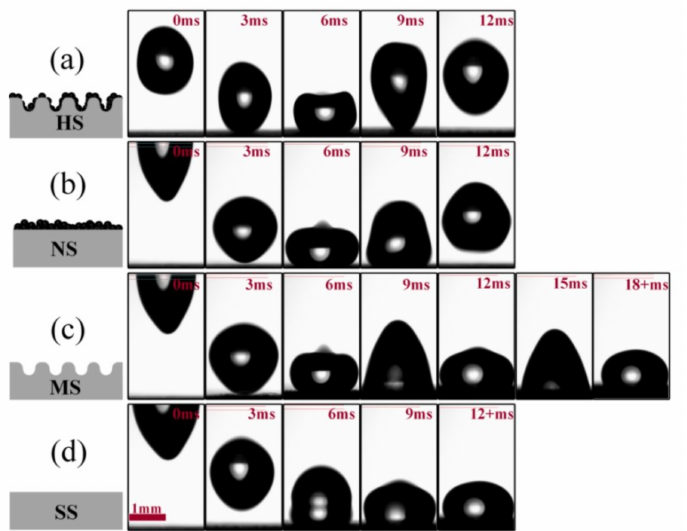
Figure 7. Schematic diagram of droplet bouncing process on the sample surface ( a ) droplets on the surface of HS; ( b ) droplets on the surface of NS; ( c ) droplets on the surface of MS; ( d ) droplets on the surface of